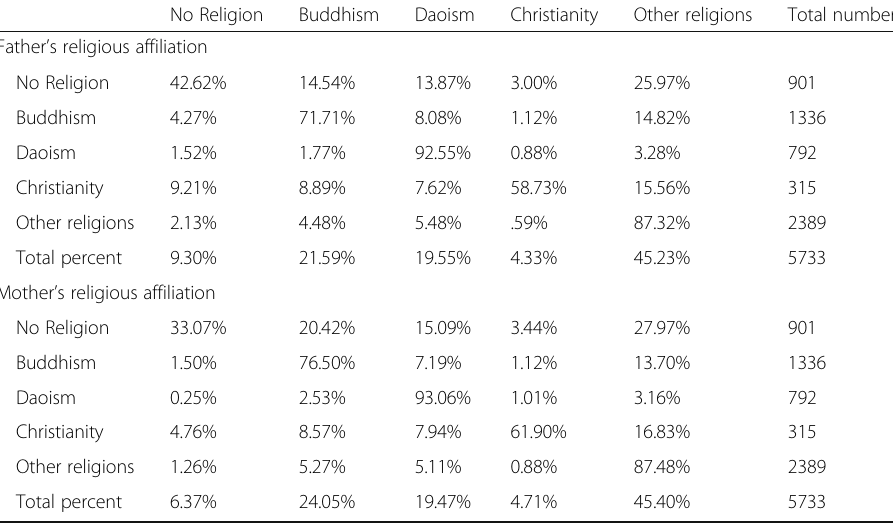
Table 3 Cross-tabulation of parent and child religious